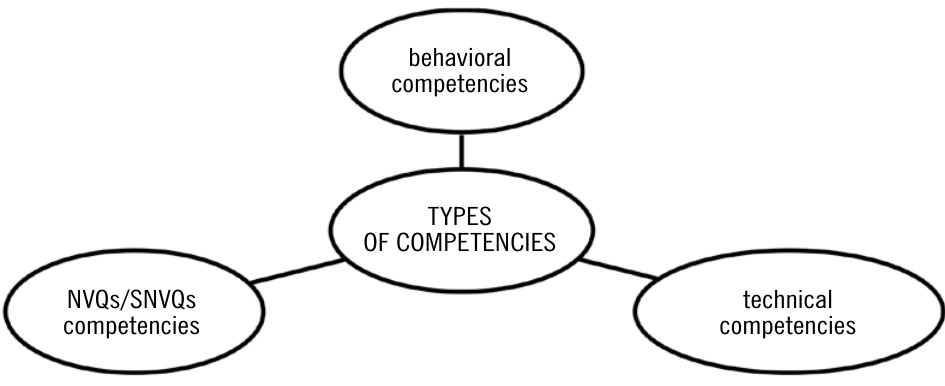
Source: own elaboration of Armstrong and Taylor